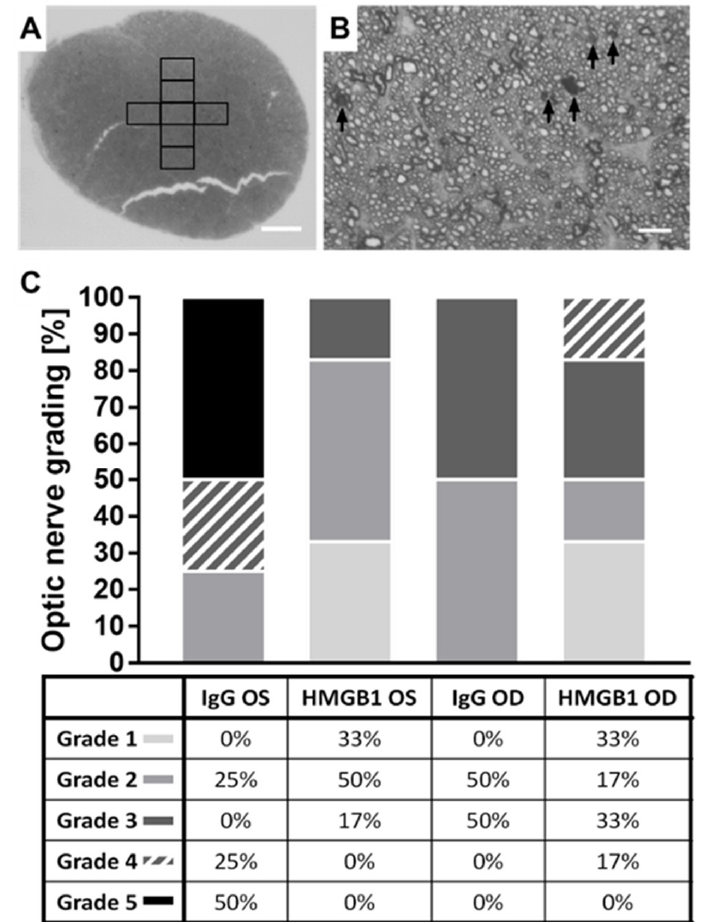
Figure 5. Grading of optic nerve cross-sections. The increased IOP causes damage to the axon bundles, the degree of which was analyzed by the number of collapsed axons in PPD-stained cross-sections of the optic nerves. An overview image was acquired using the 10 × objective ( A , scale bar: 100 µ m). Seven tile scans from different areas of the optic nerves were acquired using the 100 × oil objective ( B , scale bar: 10 µ m). The number of collapsed axons was determined. Grades were determined based on the highest sum of collapsed axons found in the 7 images ( C ). The sections were imaged with an upright microscope and a 100 × immersion oil objective (Olympus Vanox-T AH-2; Olympus SPlan 100 × /1.25 oil, 160/0.17, Olympus Deutschland GmbH, Hamburg, Germany).